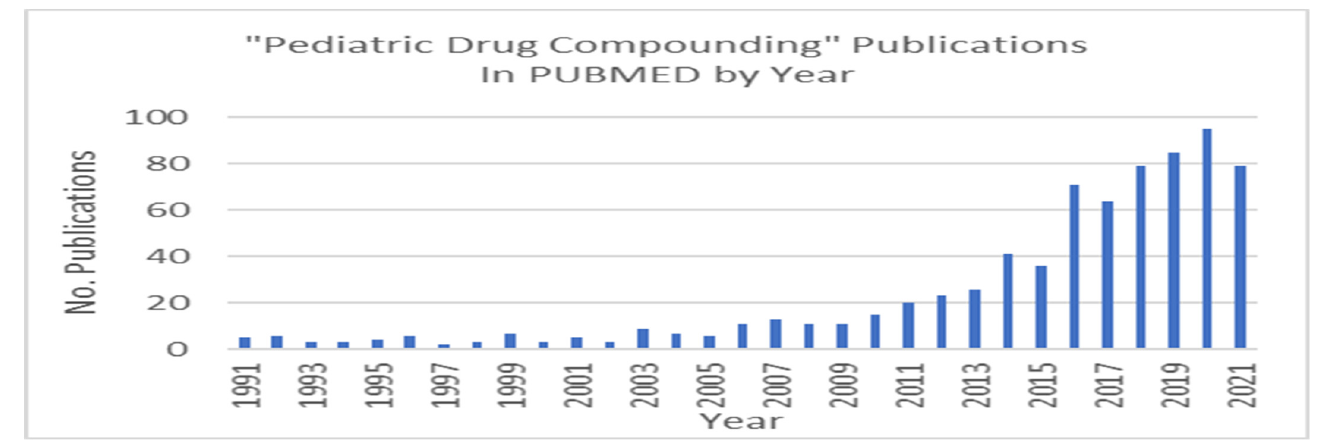
Figure 1. Number of Publications in PUBMED on the topic of pediatric drug compounding, 1991–2021 .